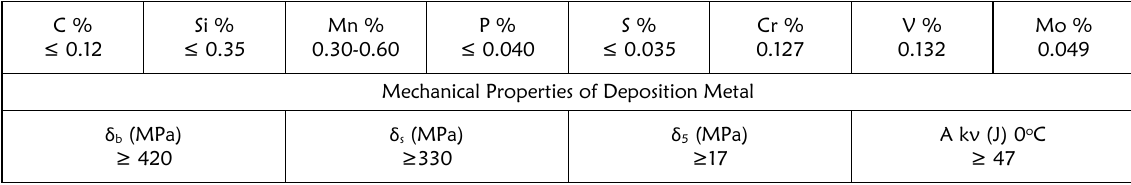
Table 4: Chemical composition & mechanical properties of welding